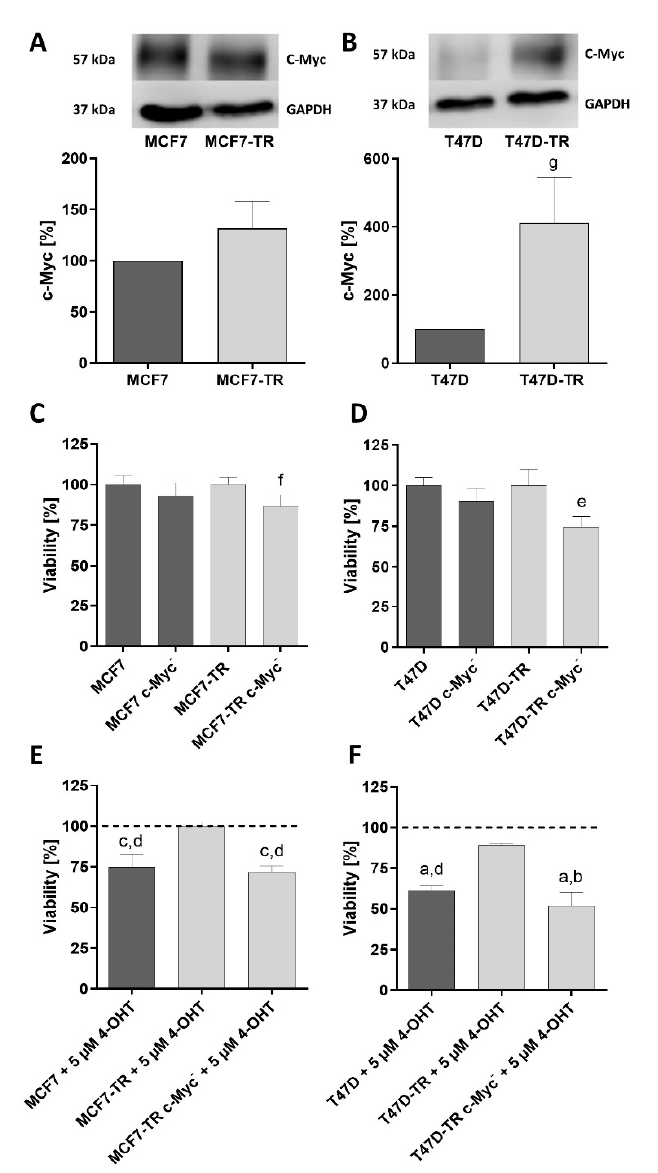
Figure 4. Comparison of c-Myc protein expression in human breast cancer cell lines MCF7 ( A ) and T47D ( B ) and their respective tamoxifen-resistant sublines. Viability of human breast cancer cell lines MCF7 ( C ), T47D ( D ) and their tamoxifen-resistant sublines MCF7-TR ( C ) and T47D-TR ( D ) after c-Myc suppression using specific siRNA. Effect of c-Myc knock down on tamoxifen efficacy on the viability of human breast cancer cell lines MCF7 ( E ), T47D ( F ) and their tamoxifen-resistant sublines MCF7-TR ( E ) and T47D-TR ( F ). Columns represent means ± SEM of data obtained from three independent experiments in three different passages of the cell lines. a, p < 0.0001 vs. control; b, p < 0.0001 vs. TR cells treated with tamoxifen; c, p < 0.001 vs. control; d, p < 0.001 vs. TR cells treated with tamoxifen; e, p < 0.0001 vs. T47D-TR control; f, p < 0.01 vs. MCF7-TR control (ANOVA followed by Tukey’s multiple comparisons test); g, p < 0.05 vs. T47D (unpaired t -test).